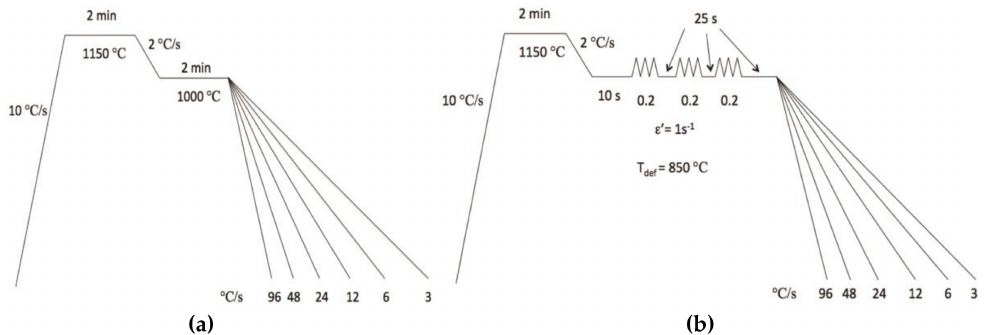
Figure 1. Gleeble simulation test plans for CCT diagrams: ( a ) without deformation, ( b ) with 3 × 0.2 prior